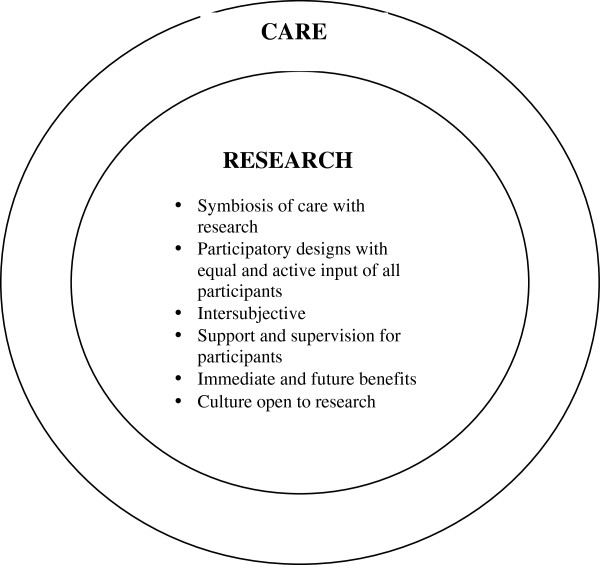
Research with care.